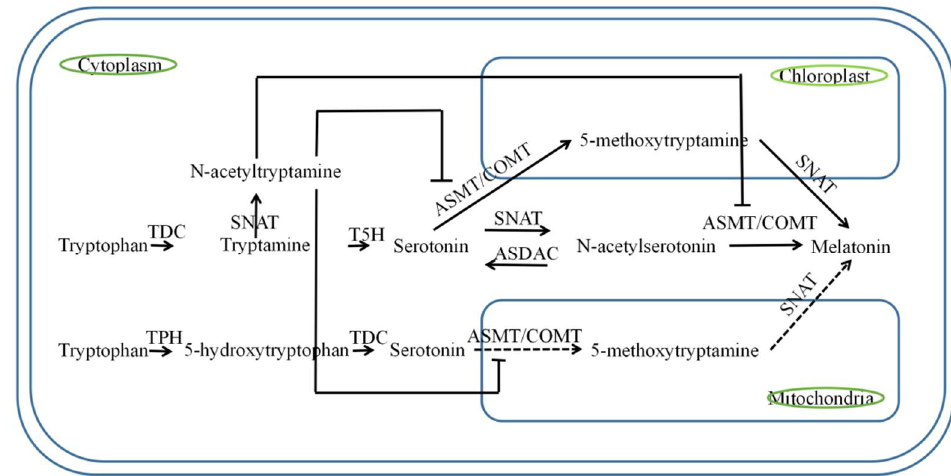
Figure 1. Biosynthetic pathway of melatonin in